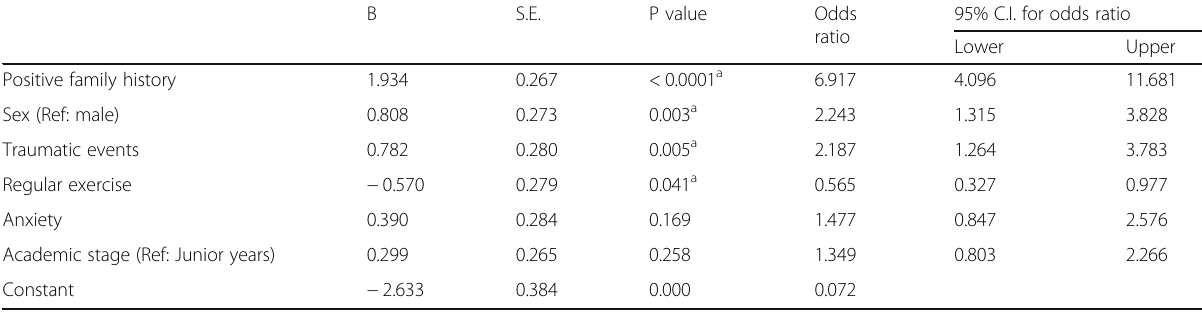
Table 7 Multivariate logistic regression to explore IBS-associated